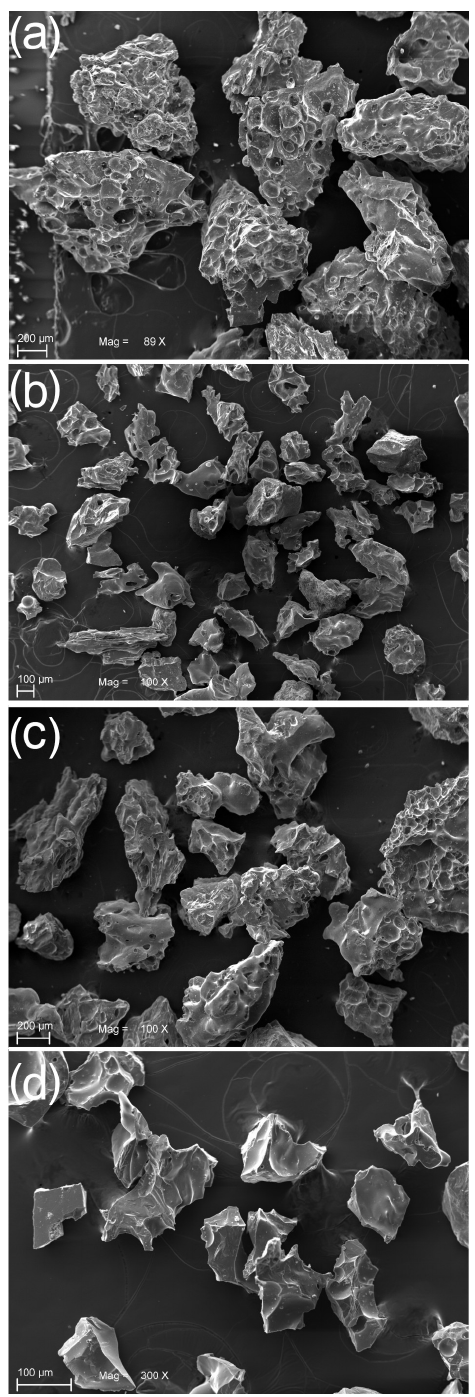
Figure 6. Scanning electron microscope secondary electrons (SEM- SE) images representative of the textures identified in studied tephra, showing moderately vesicular, glassy scoriaceous frag- ments with fluidal texture (sideromelane) and scarce poorly vesic- ular, blocky clasts (tachylite). (a, b) NSEC3 sample at Fleri; (c, d) NSEC2 sample at Acireale.